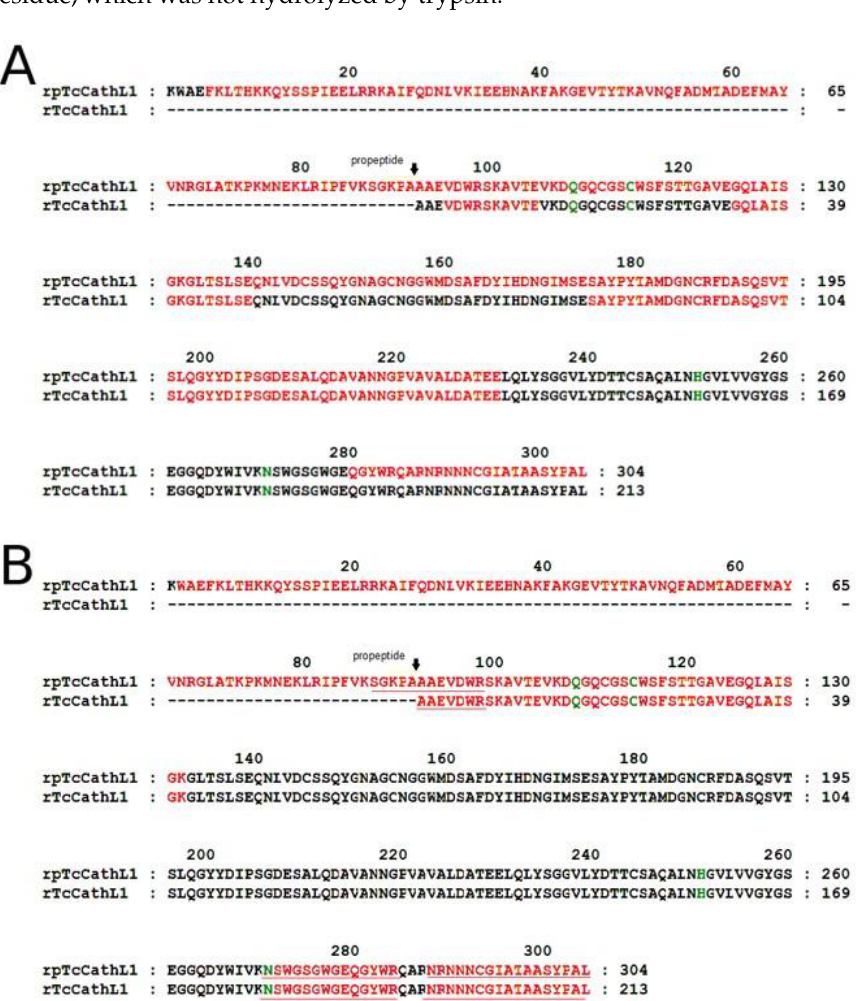
Figure 4. MS analysis of rpTcCathL1 and rTcCathL1. Peptides identified by peptide fingerprinting using matrix-assisted laser desorption/ionization time of flight mass spectrometry (MALDI-TOF MS) are marked in red; peptides sequenced by MS/MS analysis are underlined; amino acid residues of the active center are marked in green. The proposed start of the mature enzyme is indicated by a black arrow. ( A ) Hydrolysis by glutamate-specific peptidase, ( B ) hydrolysis by